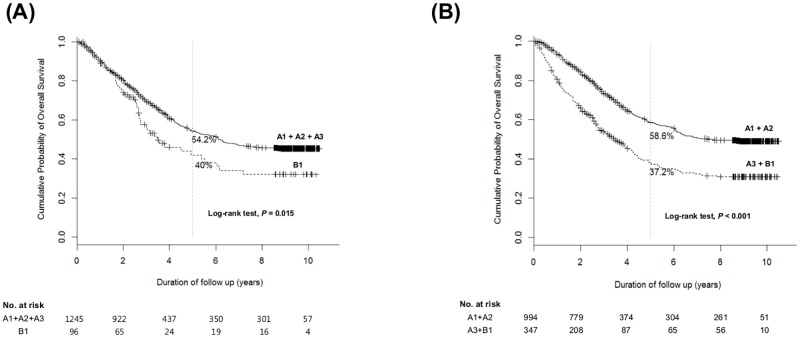
Cumulative overall survival rate of each subgrouping.(A) Overall survival rates according to subgrouping 1 (A1 + A2 + A3 vs. B1) (B) Overall survival rates according to subgrouping 2 (A1 + A2 vs. A3 + B1).